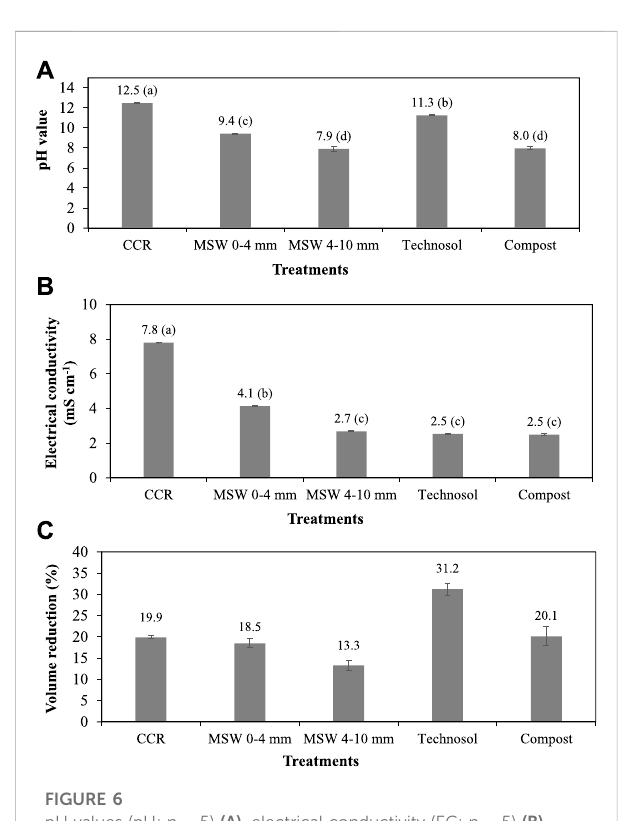
variation between treatments was found for the pH (mean 8.3) and EC (mean 15.2 mS cm -1 ) (Table 5). The evaporation of the covered columns (49.4 mm) was lower than the uncovered columns (68.4 mm), which may be due to surface exposure of the substrates to the environment during the initial 7 experimental weeks (51 days). According to the paired t-test there were signi fi cant differences between the covered and uncovered columns only for drainage amount and evaporation (amount and rate), p < 0.05.